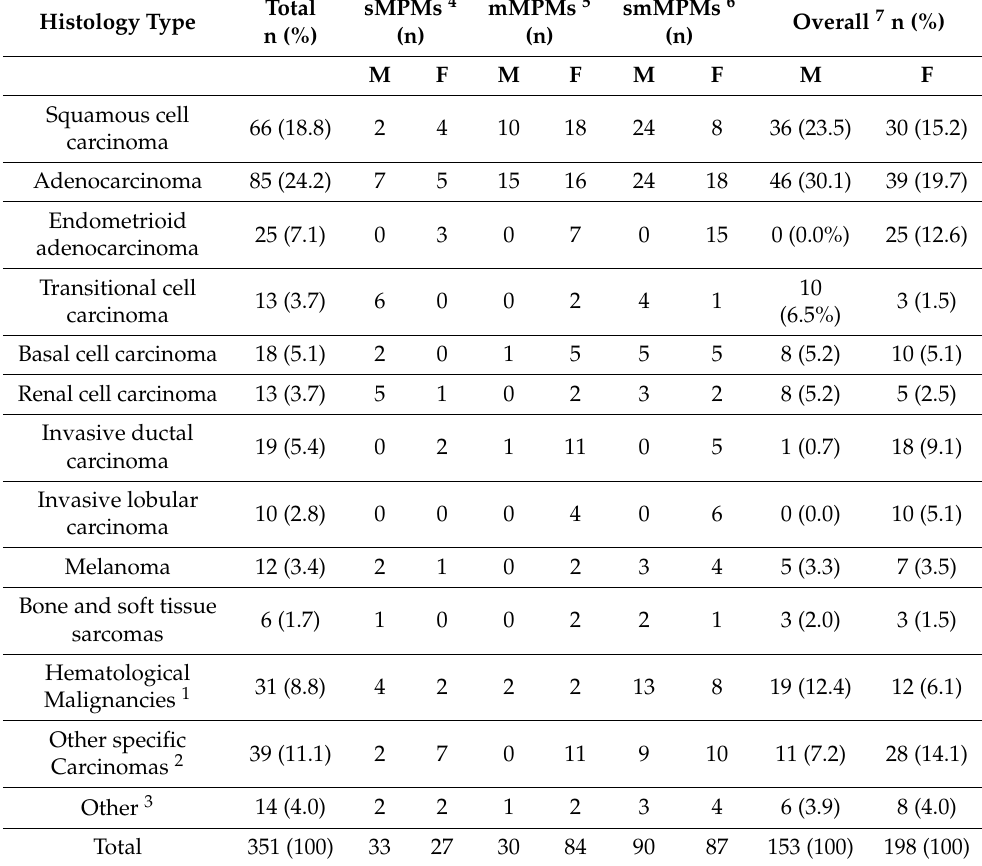
Table 4. Histological type distribution based on gender.